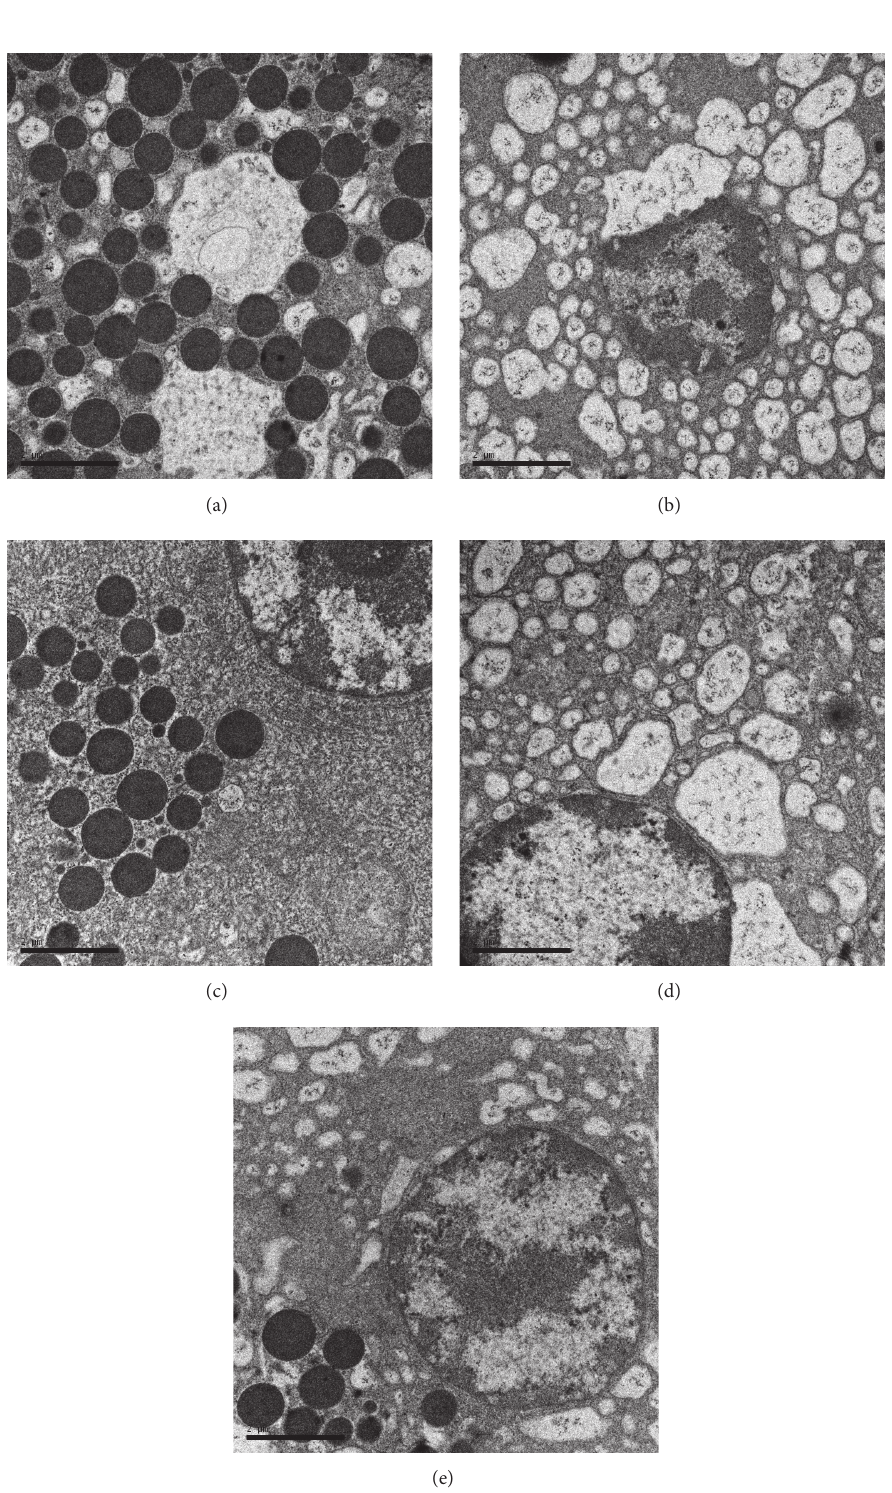
Figure 3: Performance of the pancreas by TEM. (a) SAP group at 3 h; (b) SAP group at 24 h; (c) SO group at 24 h; (d) Aca group at 24 h; (e) 3-MA group at 24 h. magnification, ×